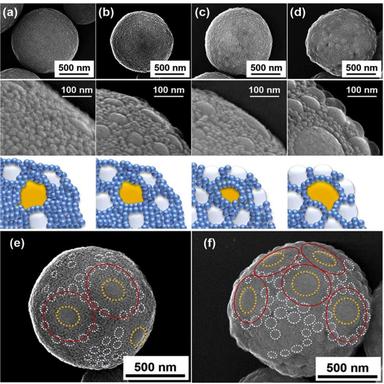
SEM images (top), HR-SEM images (middle), and schematic models (bottom) of three-component clusters of 16-, 115-, and 360-nm silica NPs with mass ratio of (a)1:2:1, (b)1:2:2, (c)1:3:3, and (d)1:5:5; Hierarchical self-organization patterns of 16-, 115-, and 360-nm silica NPs on a cluster surface with mass ratios of (e) 1:2:2 and (f) 1:5:5. Reprinted (adapted) with permission from (AIChE Journal 2017; 63 (5); 1503–1511). Copyright © 2017, Wiley.